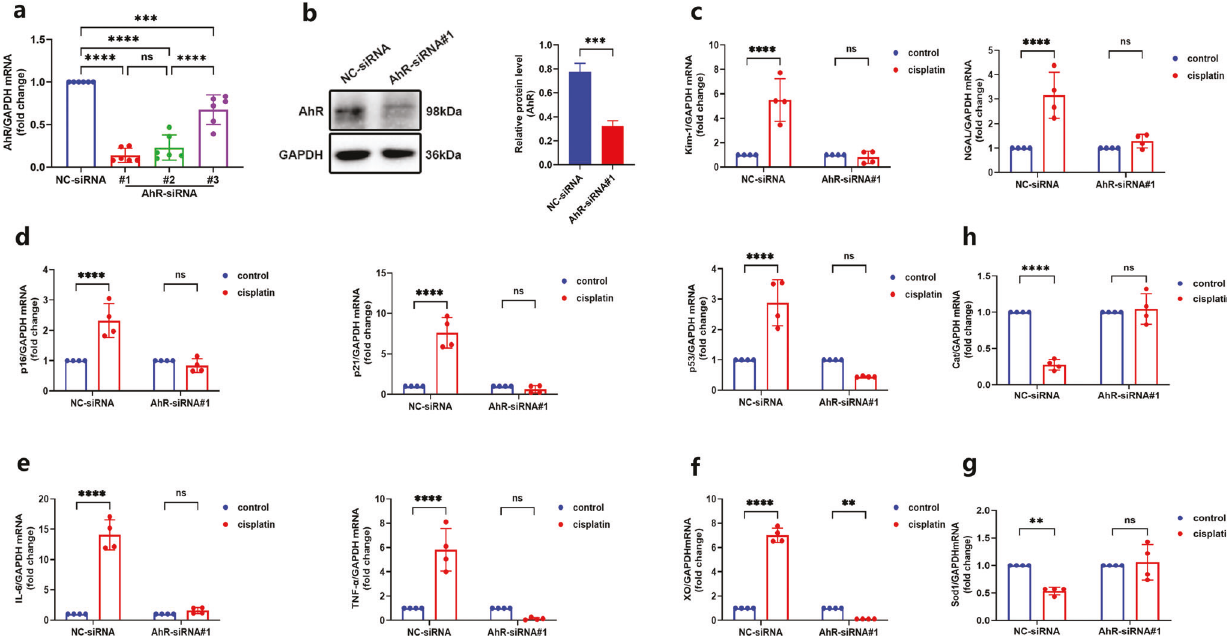
Fig. 5 AhR knockdown attenuated cellular injury and senescence as well as represses oxidative stress in cisplatin-stimulated tubular epithelial TCMK-1 cells. a Screening for suitable AhR-siRNA. b AhR protein level in TCMK-1 cells, and the relative protein level was quanti fi ed by densitometry and normalized with GAPDH ( n = 3). All western blot experiments were repeated in triplicate. c Transcript expression of Kim- 1 and NGAL in TCMK-1 cells with or without cisplatin stimulation ( n = 4). d Transcript expression of SAGs (p16, p21, p53) and e SASPs (IL-1 β , IL- 6, TNF- α ) in TCMK-1 cells with or without cisplatin stimulation ( n = 4). f Oxidant (XO) and g , h anti-oxidant (Cat, Sod1) expression, measured by RT-qPCR in TCMK-1 cells with or without cisplatin stimulation ( n = 4). Data are represented as means ± SDs. cis, cisplatin. **** P < 0.0001, *** P < 0.001, ** p < 0.01, ns P >